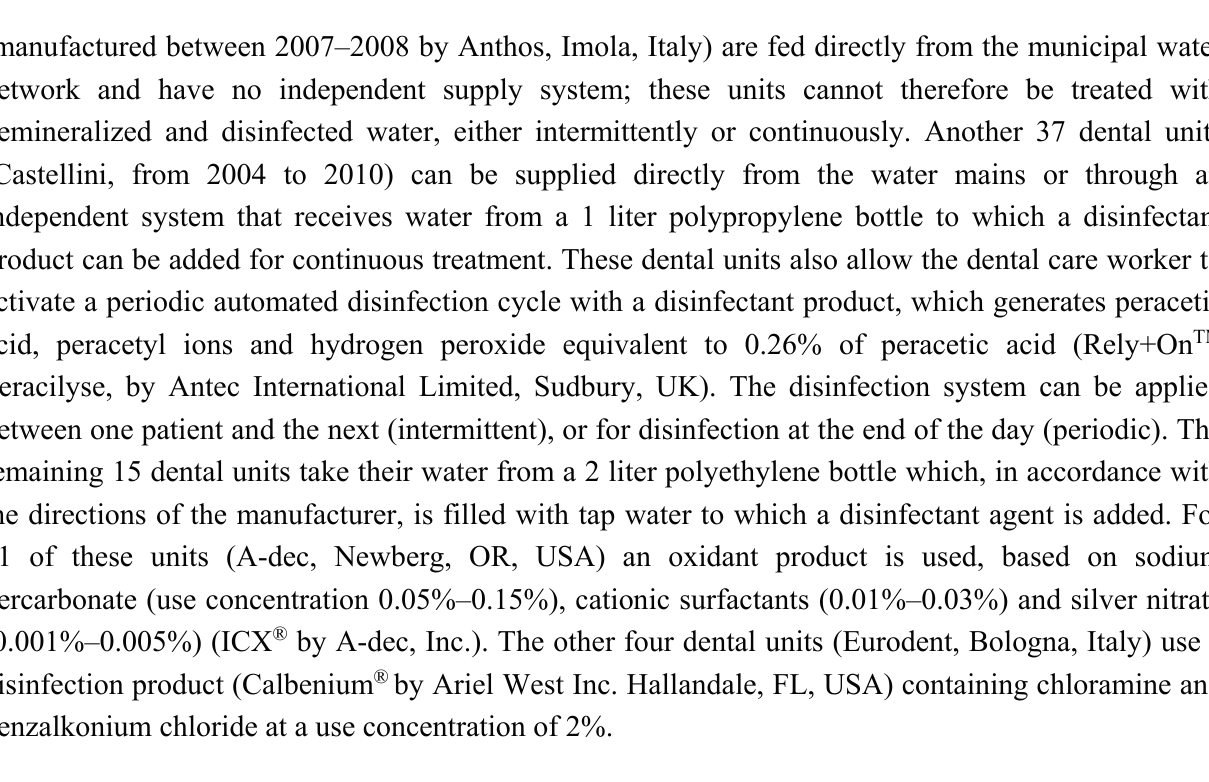
Table 1. Location of the divisions in the clinic and number of dental units treated with different types of disinfection, at